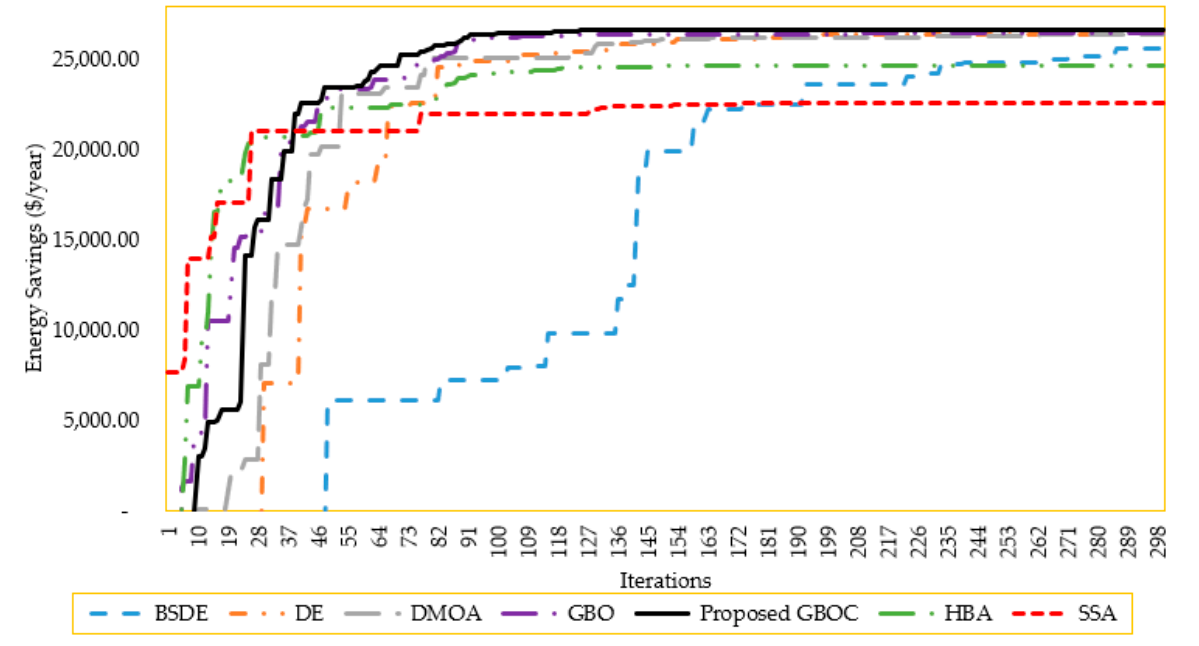
Figure 19. Convergence characteristics of GBOC, GBO, SSA, DMOA, DE, and HBA for the IEEE 69-distribution system for Scenario 2. Table 7. Obtained objectives and related accuracies of all of the applied techniques with improved compensation